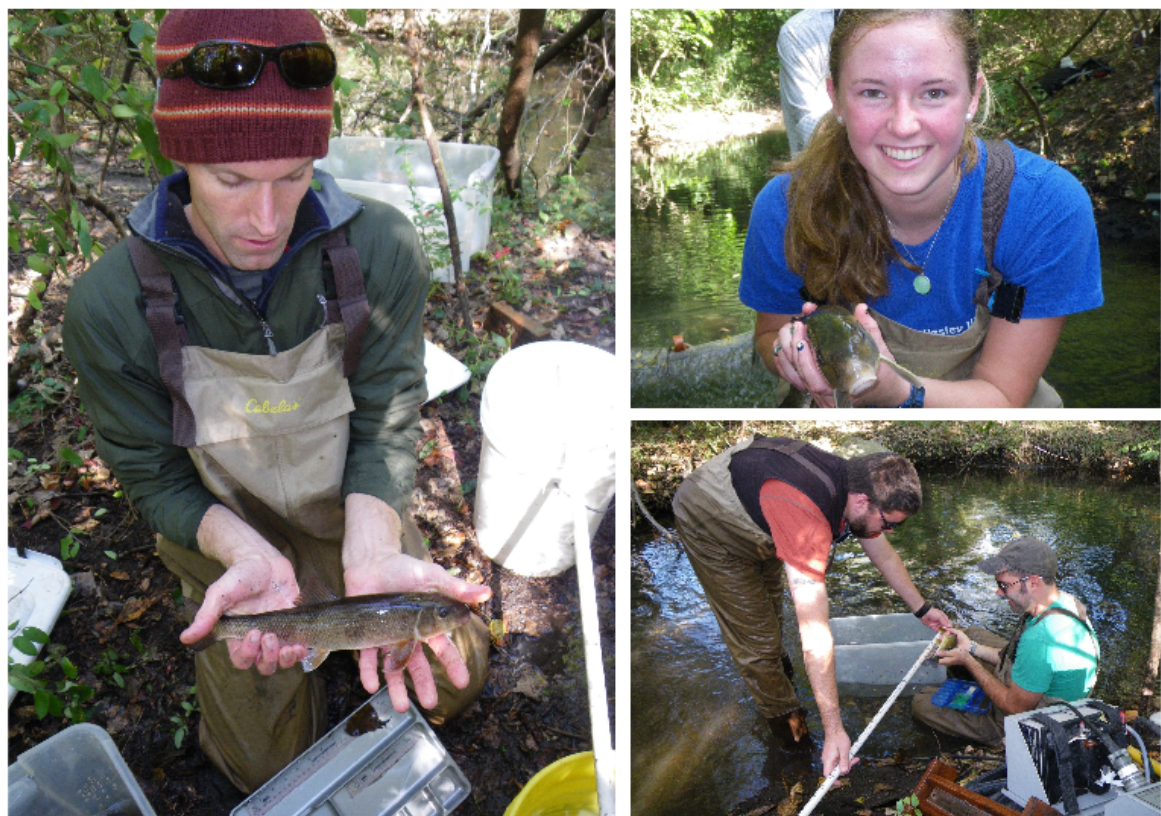
Figure A1.3. Photographs of individuals helping measure white sucker. Clockwise from left: Matthew Cooper on Oct. 5, 2010, Melanie Runkle on Sep. 11, 2013, and L. Scott Parkinson helping Michael Brueseke on Oct. 8, 2010. Sucker were a component of the diet of the native Potawatomi and Miami Peoples, the previous caretakers of watersheds like Juday